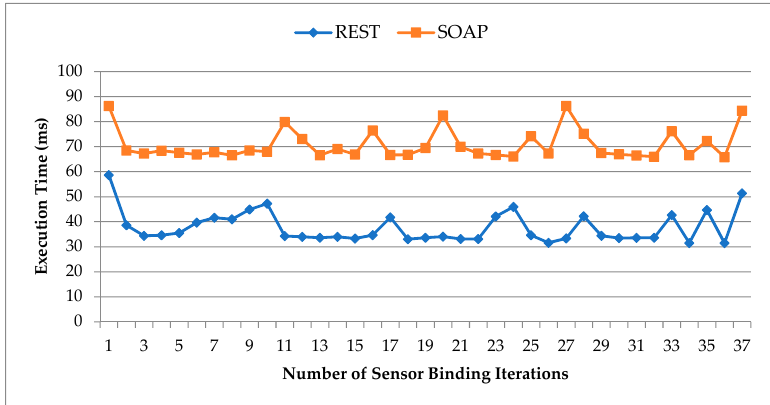
Figure 16. Execution time comparisons for geo-context based sensor binding.